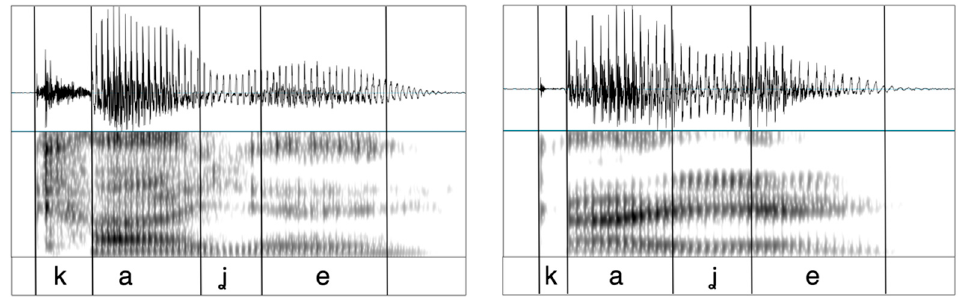
Figure 2. Spectrogram and waveform of < calle > ‘street’ produced by a native English speaker ( left ) and a native Spanish speaker ( right ). The difference in VOT is visible in the phoneme /k/. Relevant for the GAR task, the five utterances contained a wide variety of segments (i.e., consonants and vowels). Several segments were included that differ significantly in English and Spanish phonetic production (e.g., word-initial <r>, which is produced as / ɹ / in English and /r/ in Spanish), which could potentially serve as markers of English-accented Spanish. In addition, several segments were included that differ across different dialects of Spanish (e.g., <z>, <ci>, and <ce>, are produced as /s/ in most dialects of Spanish, but as / θ / in Peninsular Spanish), which could potentially serve as markers of the local (Peninsular) dialect of